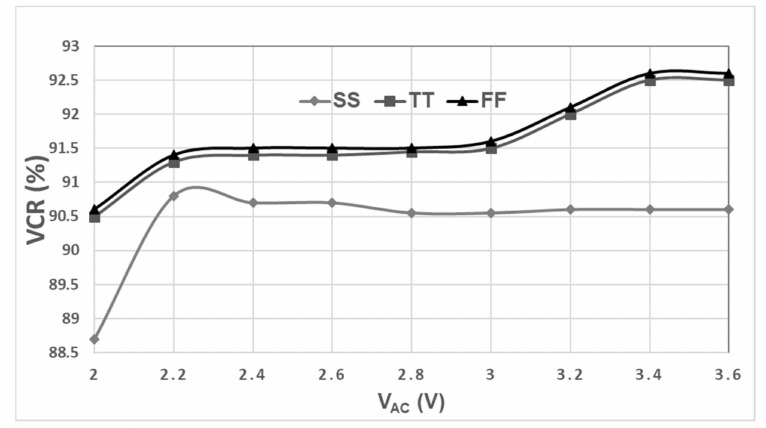
Figure 9. Voltage conversion ratio (VCR) versus different input voltage.